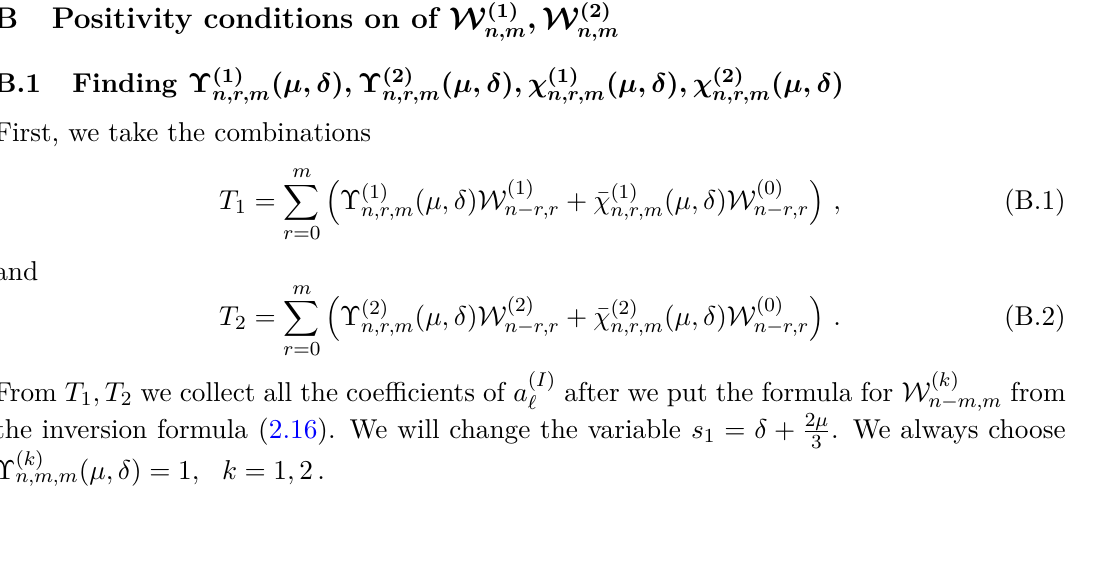
for n − m,m for m > n − m,m